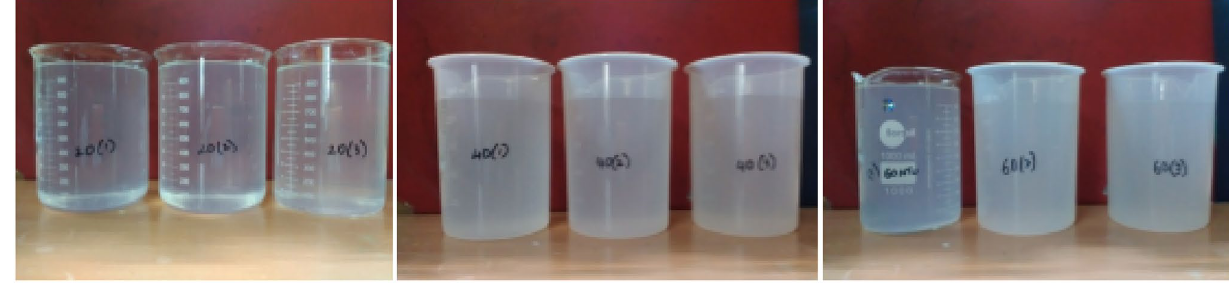
Fig. 3 Synthetic samples